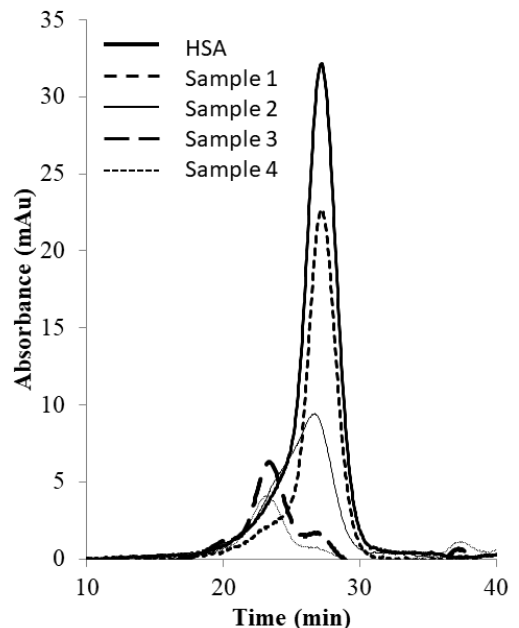
Figure 7. SEC chromatograms of samples obtained by stirred cell membrane filtration-based hybrid separation (sample 1: 1.65 M flow-through, sample 2: 1.5 M eluate, sample 3: 1.35 M eluate, sample 4: 0 M eluate).